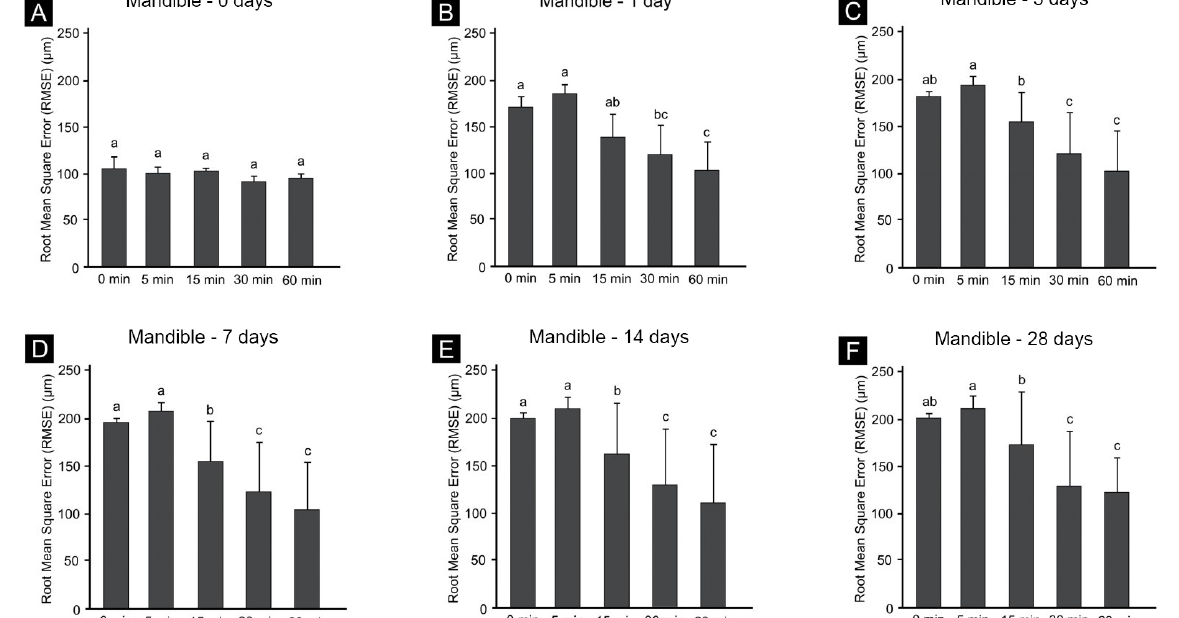
Figure 6. RMSE values at ( A ) 0 days, ( B ) 1 day, ( C ) 3 days, ( D ) 7 days, ( E ) 14 days and ( F ) 28 days after the mandible printing process. Data are mean and standard-deviation values. Different lowercase letters in the same graph indicate significant